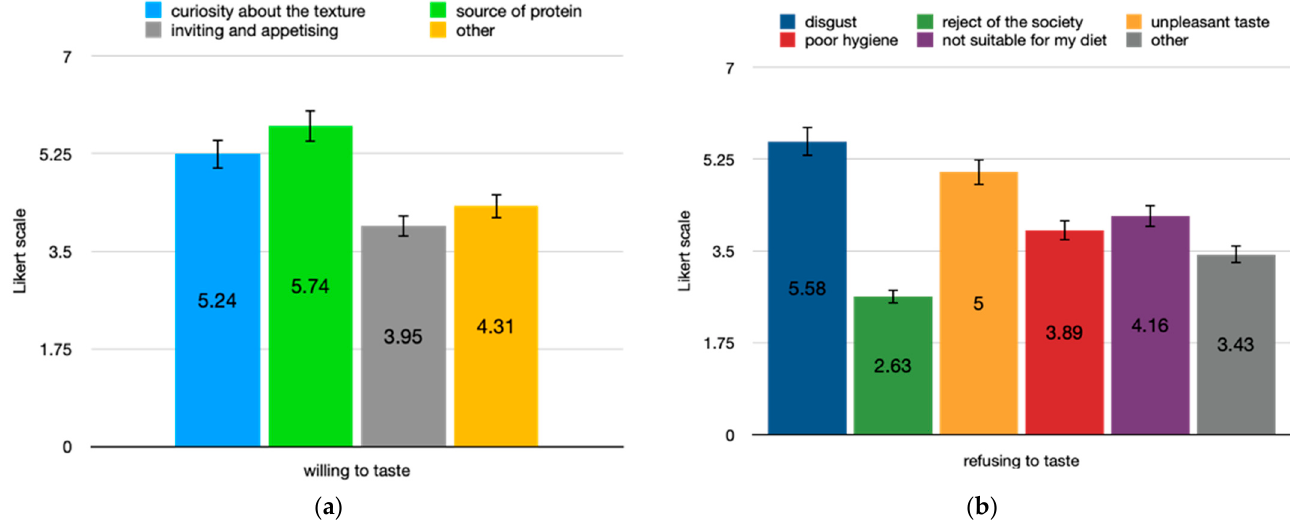
Figure 3. Reasons to taste or refuse cricket bar among the athletes. Difference in mean score in Likert scale, ranging from 1 = strongly disagree to 7 = strongly agree on the motivations ( a ) to taste or ( b ) refuse the cricket bar.